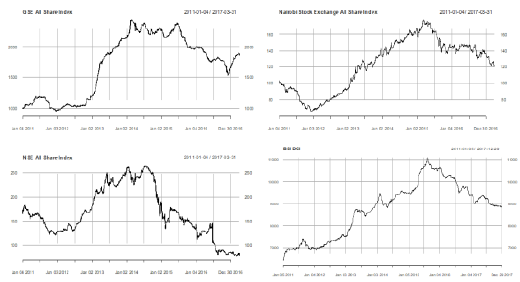
Figure 1. Evolution of Indices of the Stock Exchanges Of the four indices, the Nigeria Stock Exchange (hereafter NSE) index shows more gyrations culminating in a sharp market correction mid-2015. The index has been on a downward trend since. The Ghana Stock Exchange (hereafter GSE) index rose in the mid- 2011 before touch a low point at the end of 2011. It then rose sharply until it peaked in the first quarter of 2014. It stayed roughly at this level until mid-2015 when it took a nose-dived and trended downward in a sustained manner till the last quarter of 2016 when it bottomed out. The fell persistently in 2011 till the beginning of 2012 when it climbed steadily eventually peaking in the first quarter of 2015. It has since seen a sustained fall. The Botswana Stock Exchange (hereafter BSI DCI) index trended upwards albeit bobbing up and down to about the beginning of the first quarter of 2015 when it started falling and has been on that trajectory up to the end of our sample period. We plotted the log-returns of the various indices in Figure